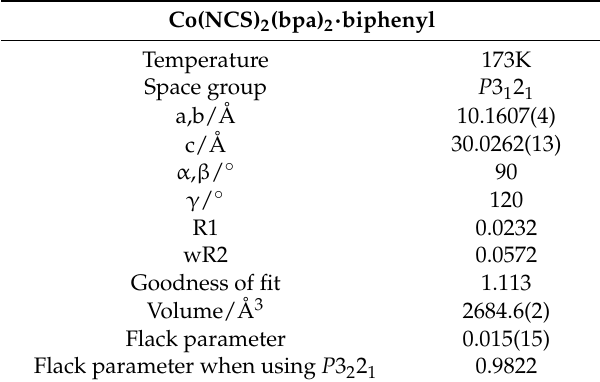
Table 3. Crystal data of [[Co(NCS) 2 (bpa) 2 ] · biphenyl] n .